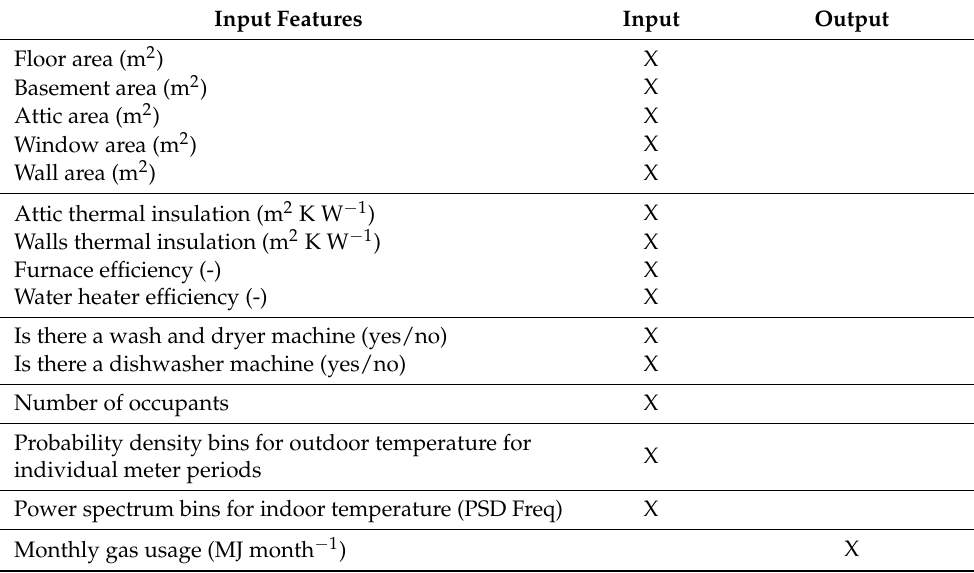
Table 4. Input features used to develop the